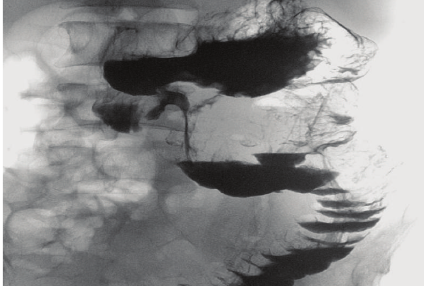
Figure 3: Barium X-ray confirming the